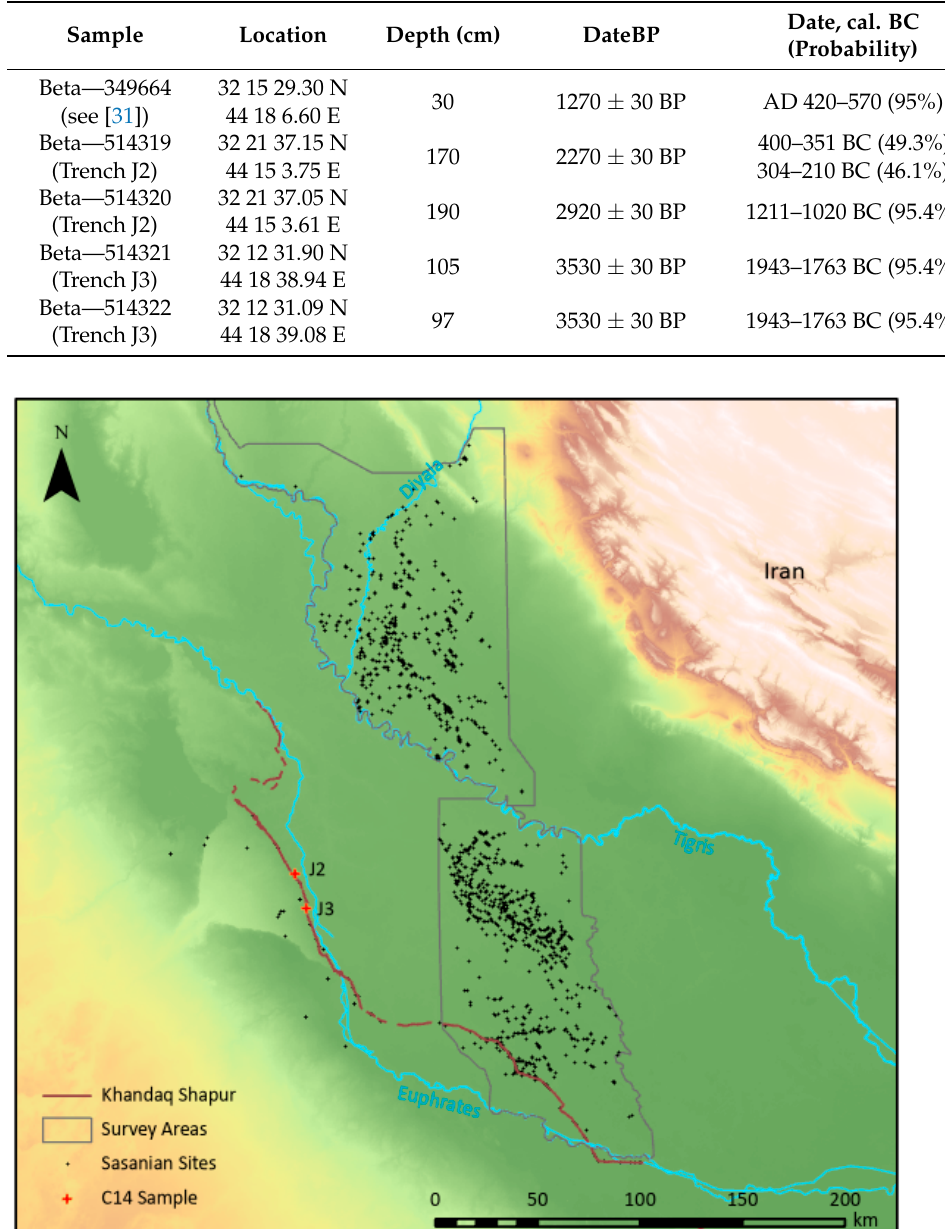
Figure 5. The Khandaq Shapur and Sasanian sites over a 90 m resolution SRTM digital elevation model. The sites are clustered into two large patches where Adams [29,32,33] conducted his surveys and along the Khandaq Shapur where Jaafar Jotheri, Raheem Alabdan, and Michelle de Gruchy surveyed sites along the mapped course of the feature. Notably, the Khandaq Shapur follows the edges of two alluvial